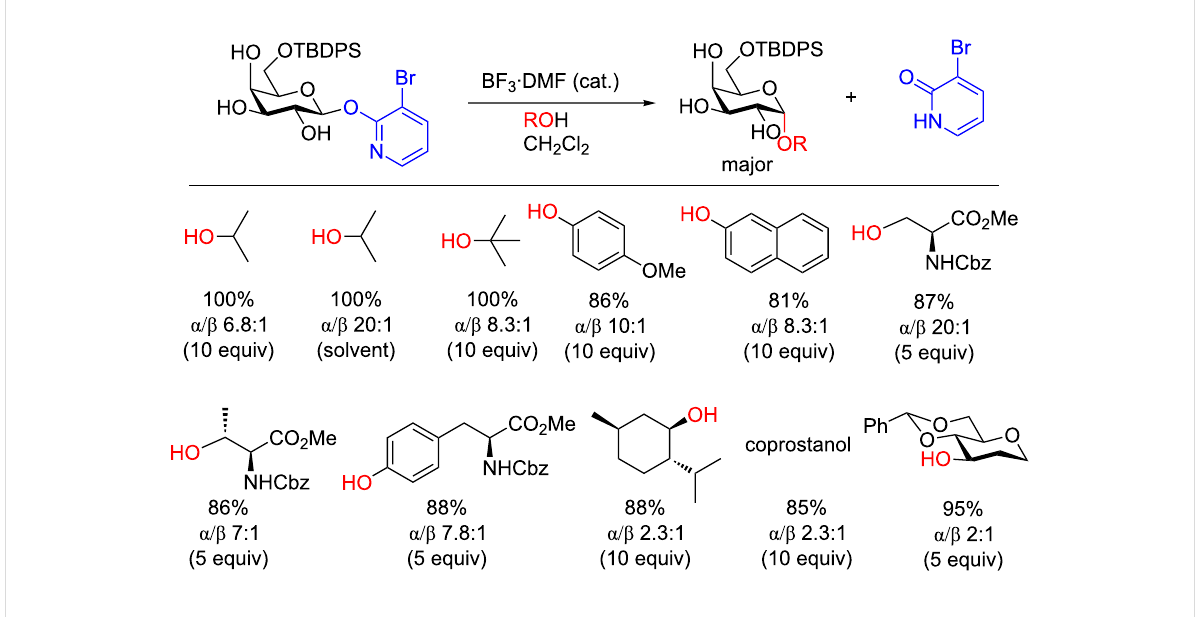
Figure 1: Synthesis of monoprotected glycosides from a (3-bromo-2-pyridyloxy) β -D-glycopyranosyl donor under Lewis acid-catalyzed conditions [42].